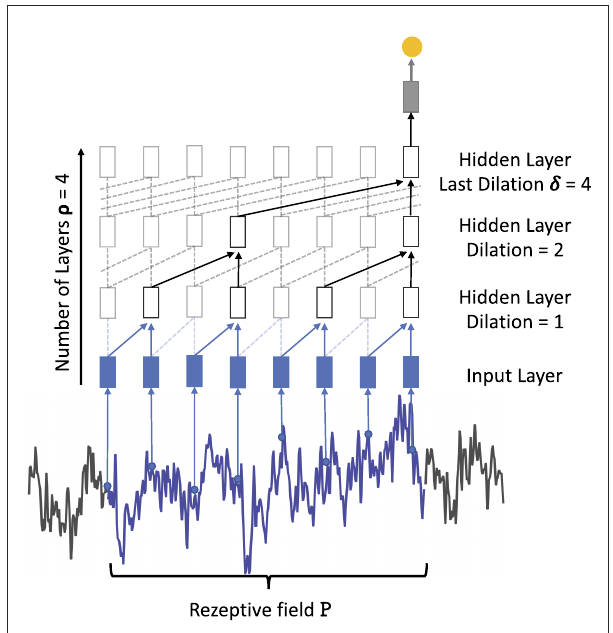
FIGURE6 Conceptual view of a Transformer block that shows a single attention layer that is typically realized as multiple attention heads. This Transformer block may be stacked multiple times and may be arranged in an encoder-decoder architecture with attention layers spanning across encoder and decoder. Figure replicated from Vaswani et al. (2017).